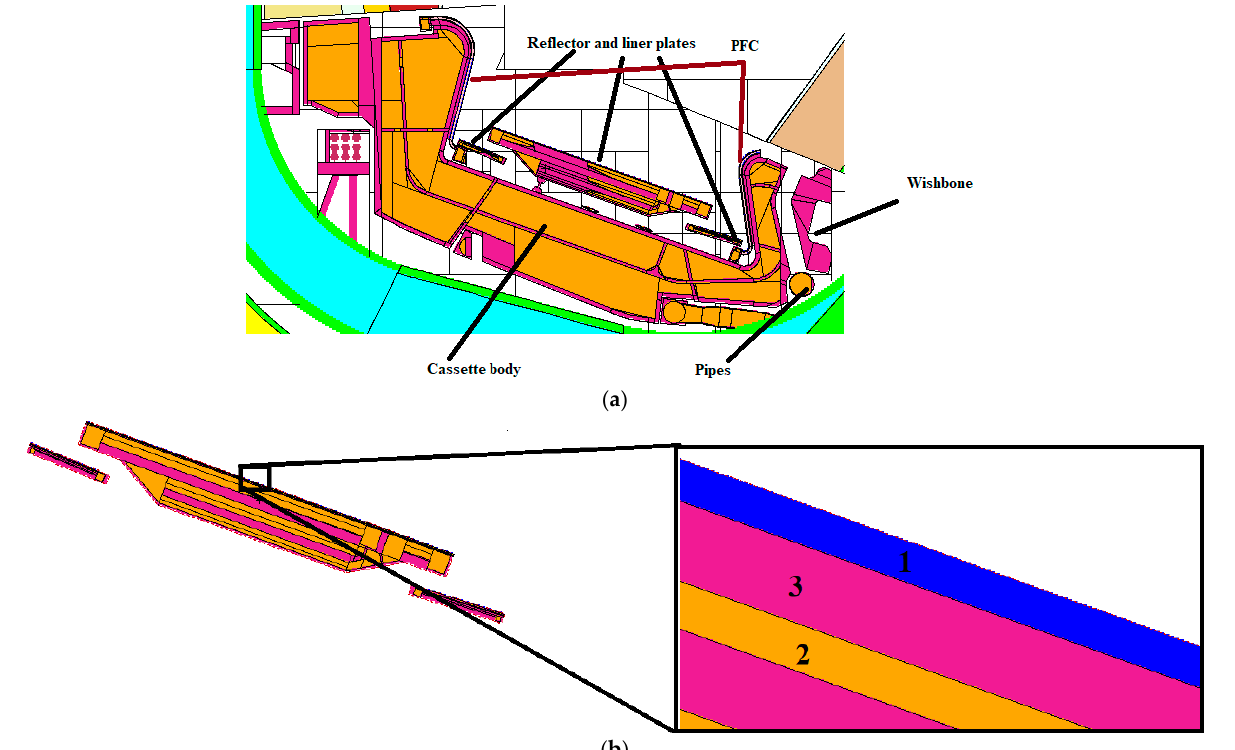
Figure 5. Divertor MCNP model: ( a ) with extracted linear and reflector plates; ( b ) 1—Tungsten, 2—Water, 3—Eurofer layers. (PFC—Plasma Facing Component). Table 2. Divertor linear and reflector plates material composition (wt%).